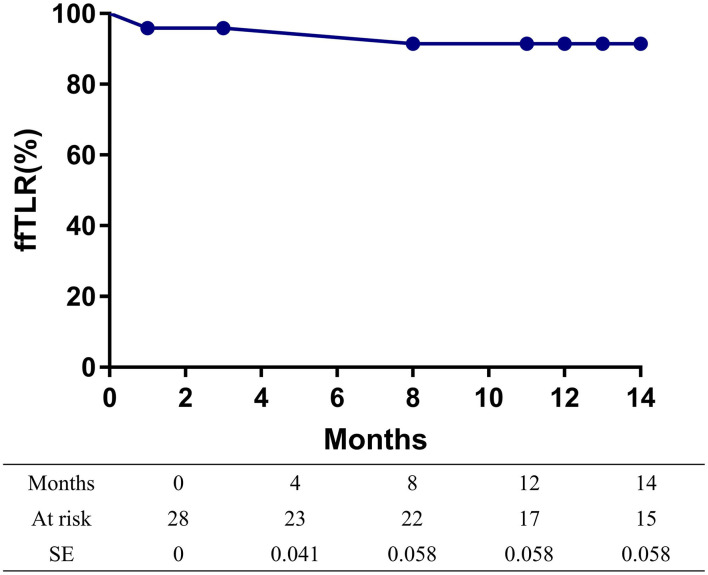
Kaplan-Meier curves of the freedom from target lesion revascularization (TLR) of patients.